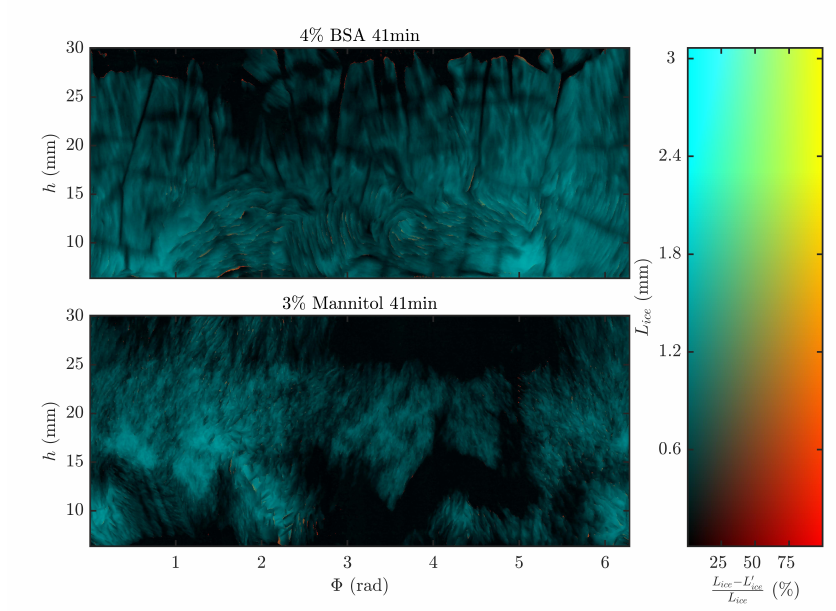
Figure 4. Graphical representation of the relative difference of the frozen product thickness ( L ice ) and integrated frozen product length ( L (cid:48) ) for every ( Φ , h ) coordinate by means of a 2D-colour scale (right) ice for 4% BSA (top left) and 3% mannitol (bottom left) at 41